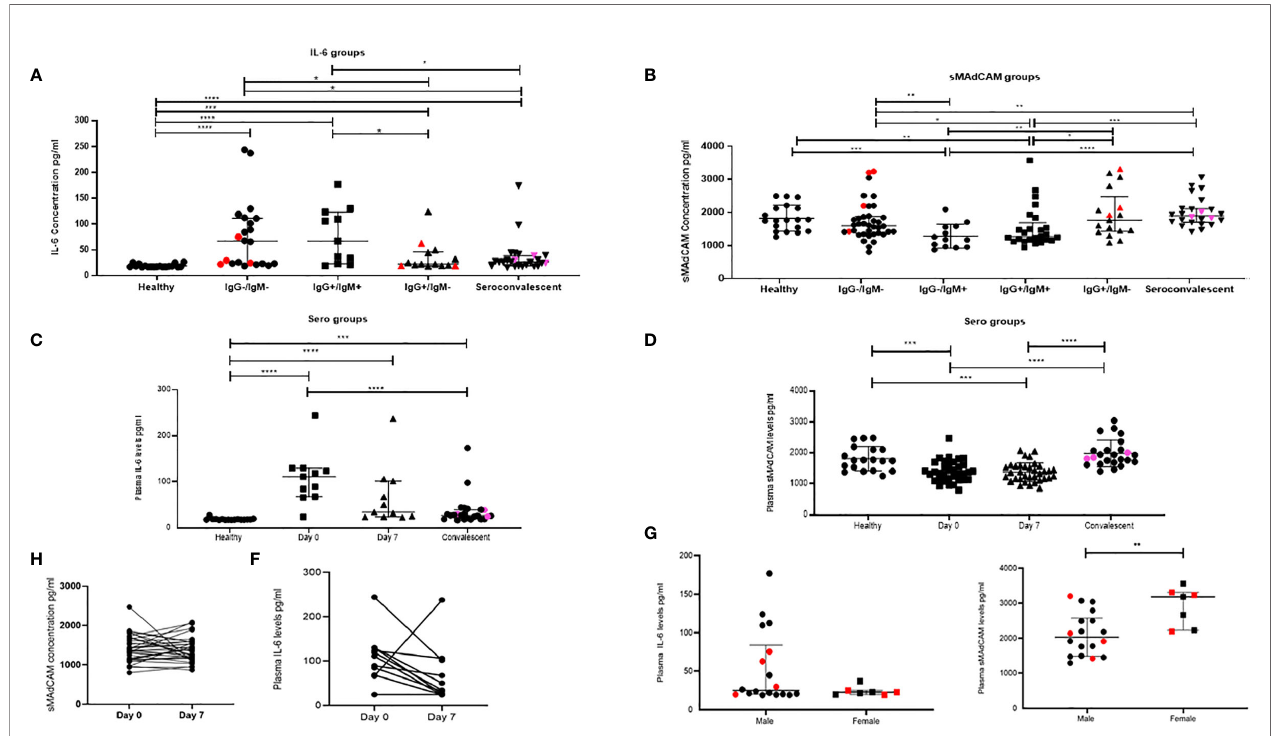
FIGURE 1 | Dynamic changes in plasma in fl ammatory markers in study participants. Variation in levels of (A) IL-6 in 16 healthy, seronegative controls, in-patients — IgG − /IgM − (n = 22), IgG+/IgM+ (n = 11), IgG+/IgM − (n = 14), and sero-convalescent (n = 24) groups. (B) Soluble MAdCAM concentration in 19 healthy, seronegative controls, in-patients — IgG − /IgM − (n = 38), IgG − /IgM+ (n = 13) IgG+/IgM+ (n = 25), IgG+/IgM − (n = 17), and sero-convalescent (n = 24) groups. (C) IL-6 at day 0 (n = 11), day 7 (n = 11), in convalescent (n = 22), and in healthy (n = 16) groups. (D) Soluble MAdCAM at day 0 (n = 35), day 7 (n = 35), in convalescent (n = 24), and in healthy (n = 19) groups. Change in plasma levels on follow-up (E) IL-6 (n = 11) and (F) Soluble MAdCAM (n = 35) between day 0 and day 7. Differences in plasma levels of (G) IL-6 and (H) soluble MAdCAM between male (n = 18) and female (n = 7). Red colored symbols indicate asymptomatic individuals. Pink colored symbols indicate IgG − /IgM − individuals in convalescent group. Statistical signi fi cance was calculated by Wilcoxon matched-pairs signed rank test and Mann – Whitney U-test; *p < 0.05; **p < 0.01; ***p < 0.001, and ****p <